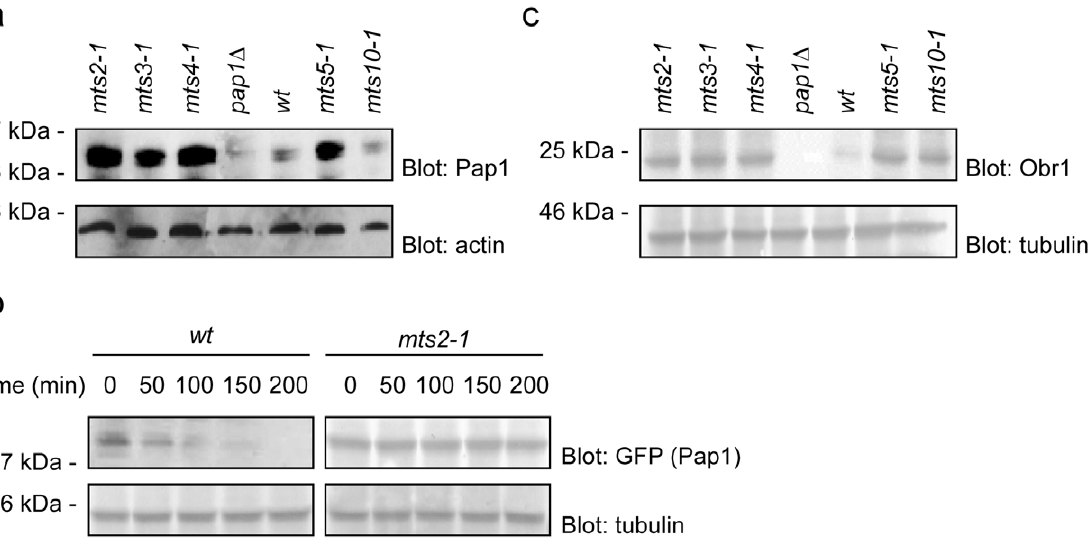
Figure 2. Stabilization of Pap1 in the mts mutants leads increased obr1 + expression. (a) To compare the steady state levels of Pap1 cell extracts of the indicated strains were prepared and analyzed by SDS-PAGE and Western blotting using antibodies to Pap1. Actin served as a loading control. Compared to wild type cells, the Pap1 levels were increased in the proteasome mutants, but not in the mts10-1 ( crm1 ) mutant. A pap1 D mutant was included as a control. (b) The degradation kinetics of GFP-tagged Pap1 was followed by blotting of wild type (wt) and mts2-1 cultures treated with cycloheximide (CHX). a -tubulin served as a loading control. In wild type cells Pap1 was rapidly degraded with a half-life of about 50 minutes. In the mts2-1 background Pap1 was stabilized (c) To compare the steady state levels of the Pap1 target Obr1 cell extracts of the indicated strains were prepared and analyzed by SDS-PAGE and Western blotting using antibodies to Obr1. Tubulin served as a loading control. Compared to wild type cells, the Obr1 levels were increased in the proteasome mutants and, as expected, in the mts10-1 ( crm1 ) mutant. No Obr1 was detected in the pap1 D mutant.